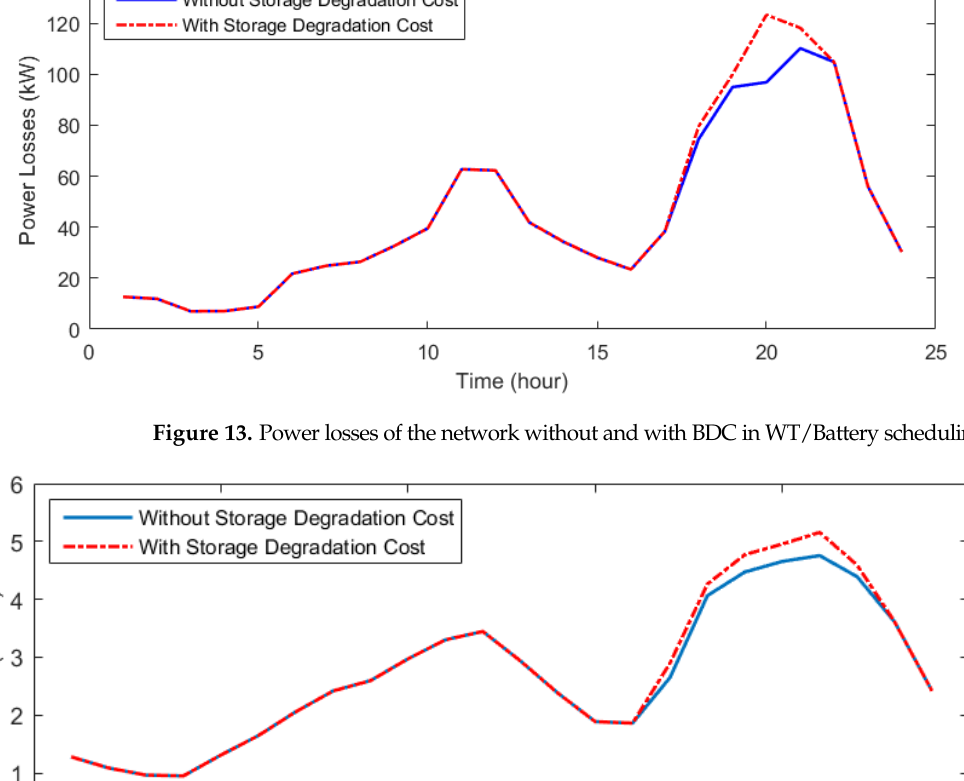
Figure 12. Battery bank energy without and with BDC in WT/Battery scheduling using the IFLA.